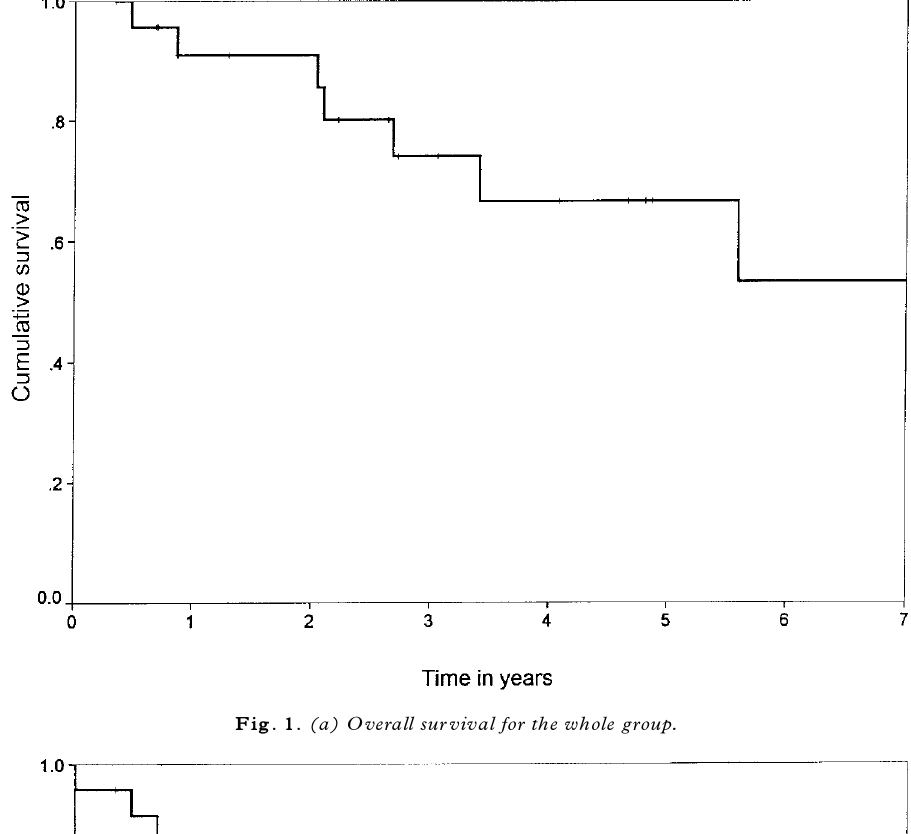
Fig. 1. (a) Overall survival for the whole group.